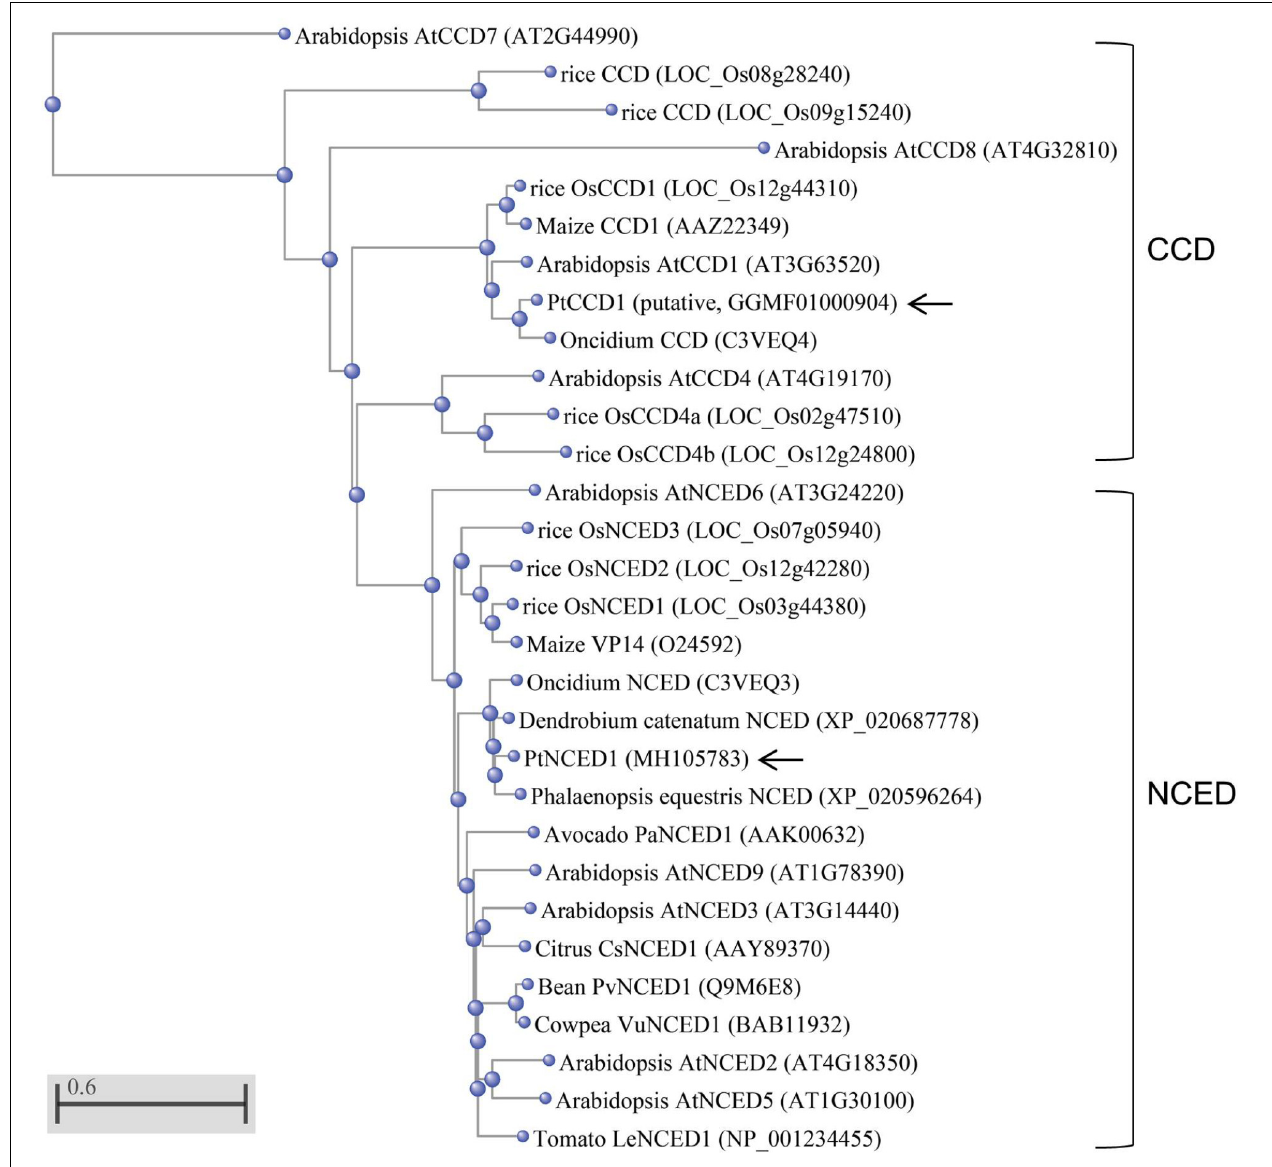
FIGURE 2 | Phylogenetic analysis of PtNCED1 and other plant NCEDs and CCDs. The PtNCED1 protein sequence was aligned with the full-length NCED/CCD members from various species by using the COBALT program with Neighbor Joining as tree method in the NCBI. The scale bar indicates a genetic distance for 0.6 amino acid substitutions per site. Of note, members with very dissimilar sequences ( > 0.5) may only be accurate in grouping but not in genetic distance. Shown in bracket are the locus names for Arabidopsis and rice, obtained from TAIR (https://www.arabidopsis.org/) and MSU (http://rice.plantbiology.msu.edu/), respectively, and the accession numbers for other species, obtained from the NCBI. For rice, members of CCD and NCED follow the names given in Tan et al. (2003). PtNCED1 and PtCCD1 obtained in this study are denoted by